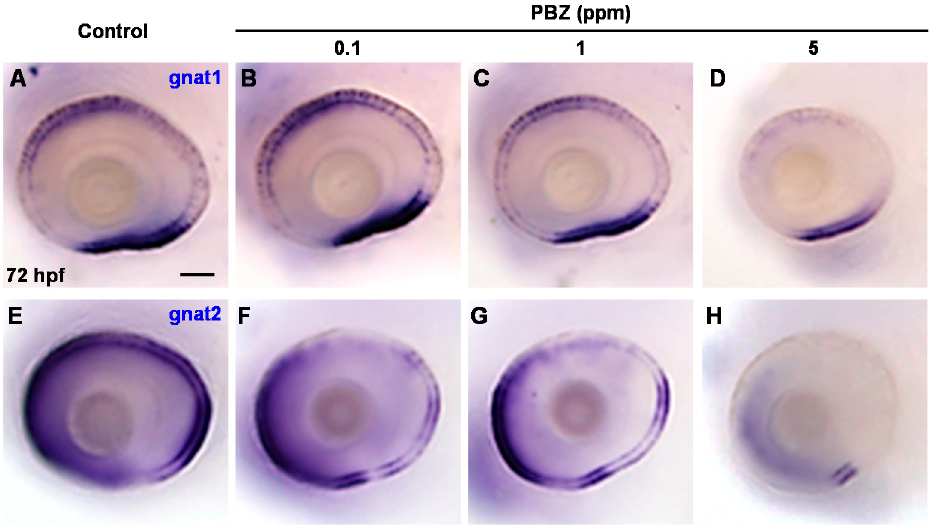
Figure 3. Paclobutrazol interferes the development of embryonic photoreceptor cells in zebrafish. Eyes of 72 hpf embryos treated with ( A , E ) 0.1% DMSO (control) or with ( B , F ) 0.1 ppm, ( C , G ) 1 ppm, or ( D , H ) 5 ppm of PBZ and labeled with riboprobes for gnat1 (rod cell marker) ( A – D ) or gnat2 (cone cell marker) ( E – H ) by in situ hybridization. Each group contains at least 20 embryos; Scale bar: 50 μ m.